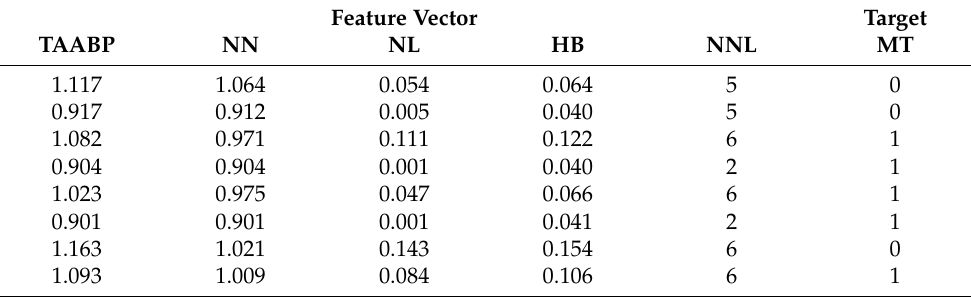
Table 2. Data representation for ML.